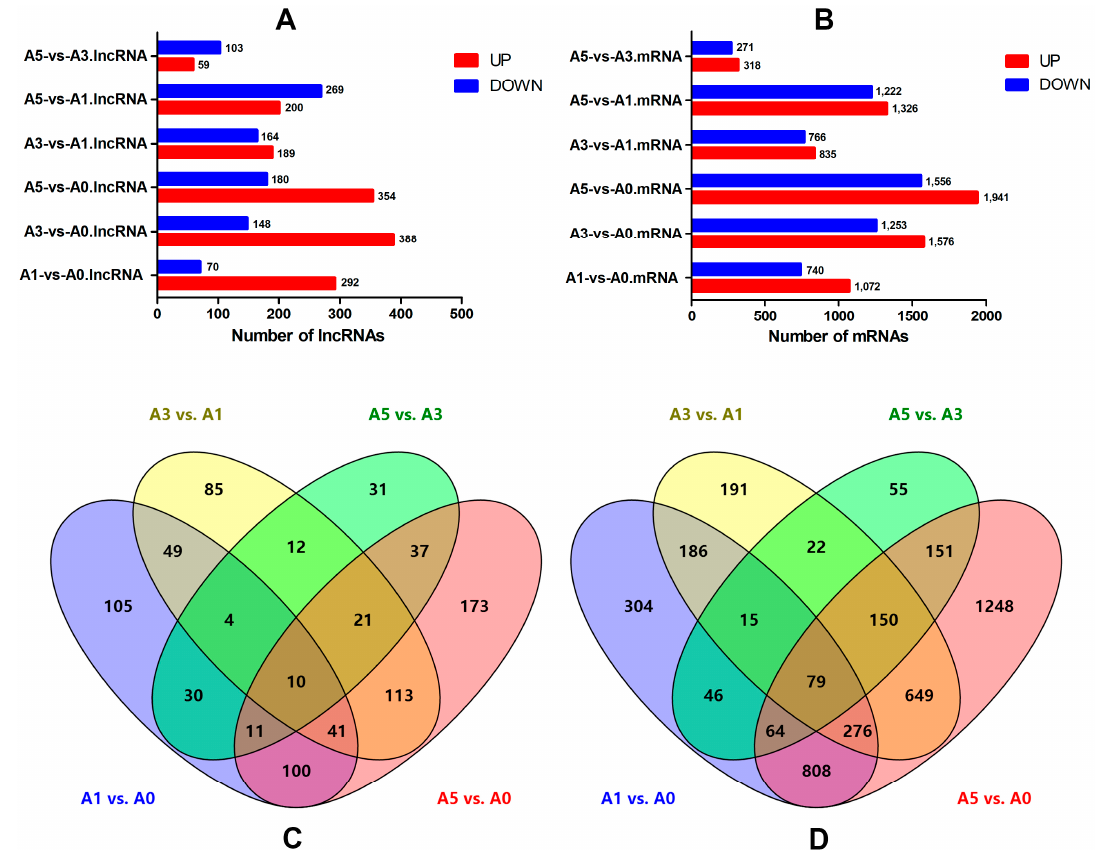
Figure 4. Differentially-expressed lncRNA and mRNA in chicken primary myoblasts at four differentiation stages. ( A ) The number of up-regulated and down-regulated lncRNAs; ( B ) the number of up-regulated and down-regulated mRNAs; ( C ) a Venn diagram of differentially-expressed lncRNAs in four comparisons (A1 vs. A0, A3 vs. A1, A5 vs. A3 and A5 vs. A0); and ( D ) a Venn diagram of differentially-expressed mRNAs in four comparisons (A1 vs. A0, A3 vs. A1, A5 vs. A3, and A5 vs. A0).